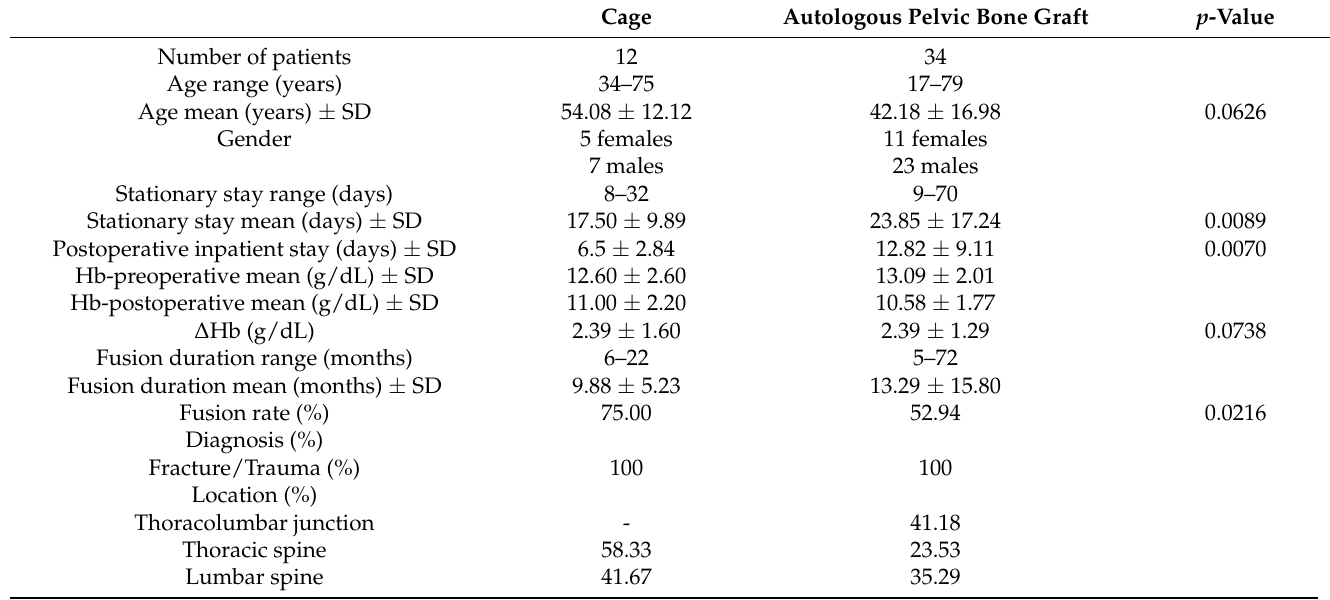
Table 1. Baseline characteristics of the